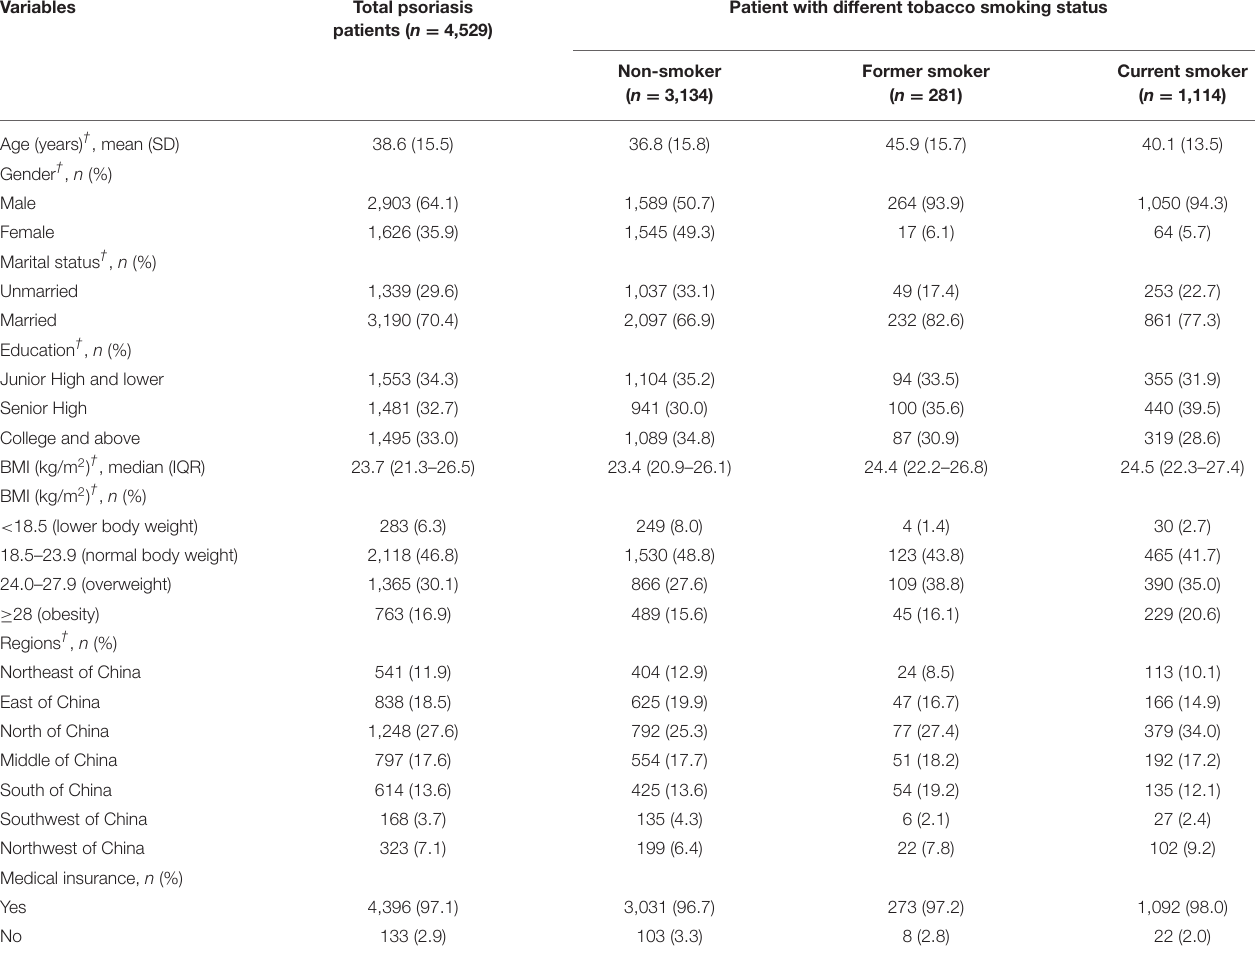
TABLE 1 | The demographic feature of psoriasis patients in China,